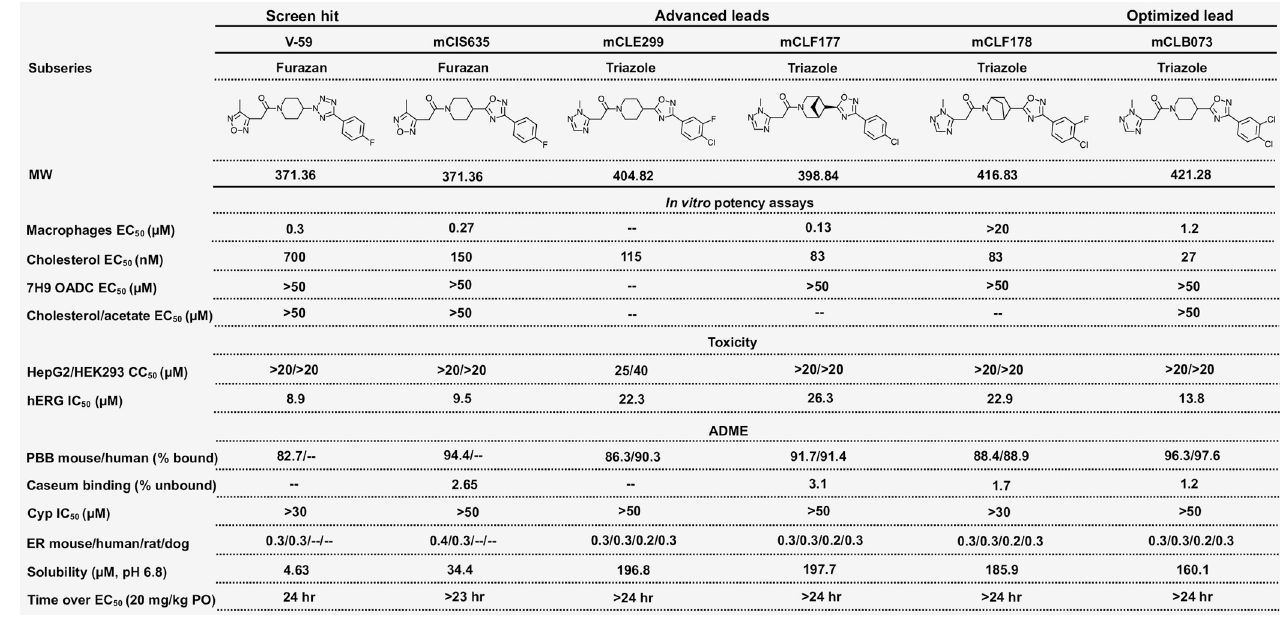
Fig 2. Structures and activities of compounds. MW, molecular weight; --, not determined; EC 50 , half-maximal effective concentration; CC 50 , 50% cytotoxic concentration; hERG, human ether- à -go-go-related gene; IC 50 , half-maximal inhibitory concentration; ADME, absorption, distribution, metabolism, excretion; PPB, plasma protein binding; Cyp, cytochrome P450; ER, extraction ratio; PO, per oral.